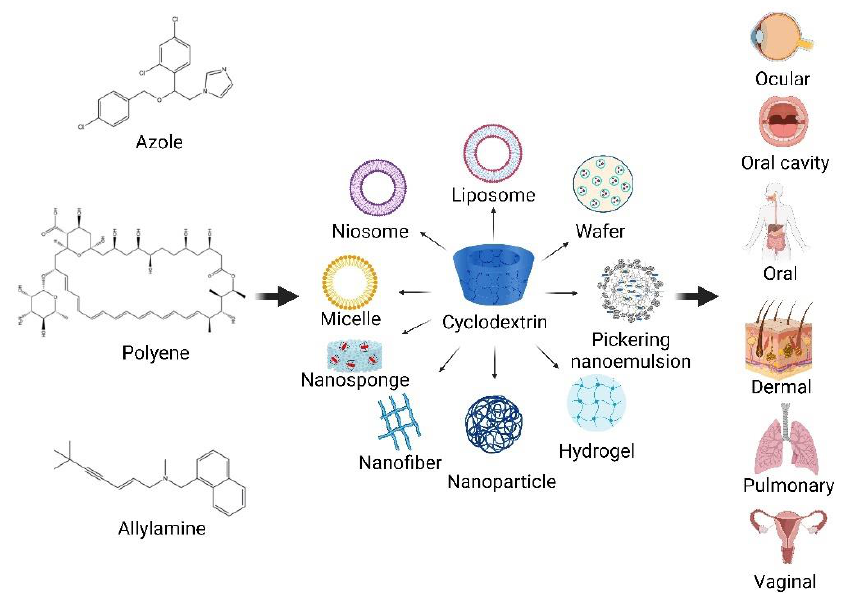
Figure 3. CD-based nanocarriers for antifungal agents in drug delivery systems (created with Bio- render.com).